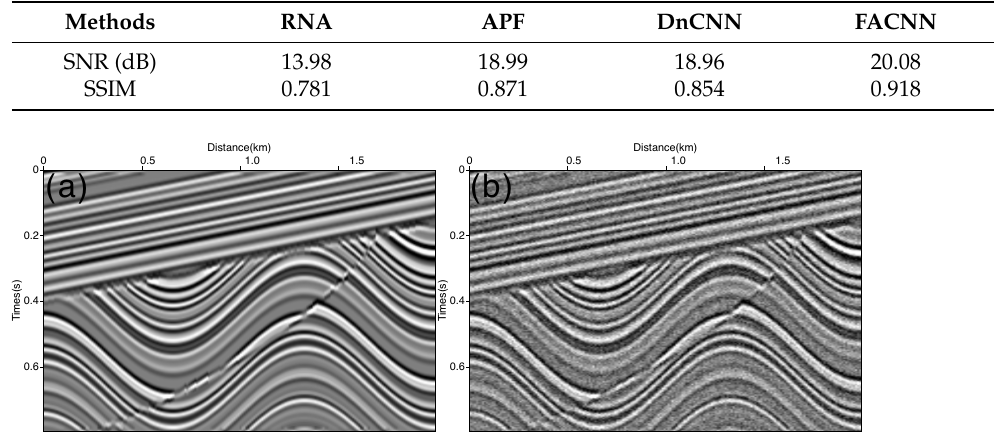
Figure 3. The diagram of the original sigmoid data and noisy data. ( a ) Original data. ( b ) Contami- nated data.